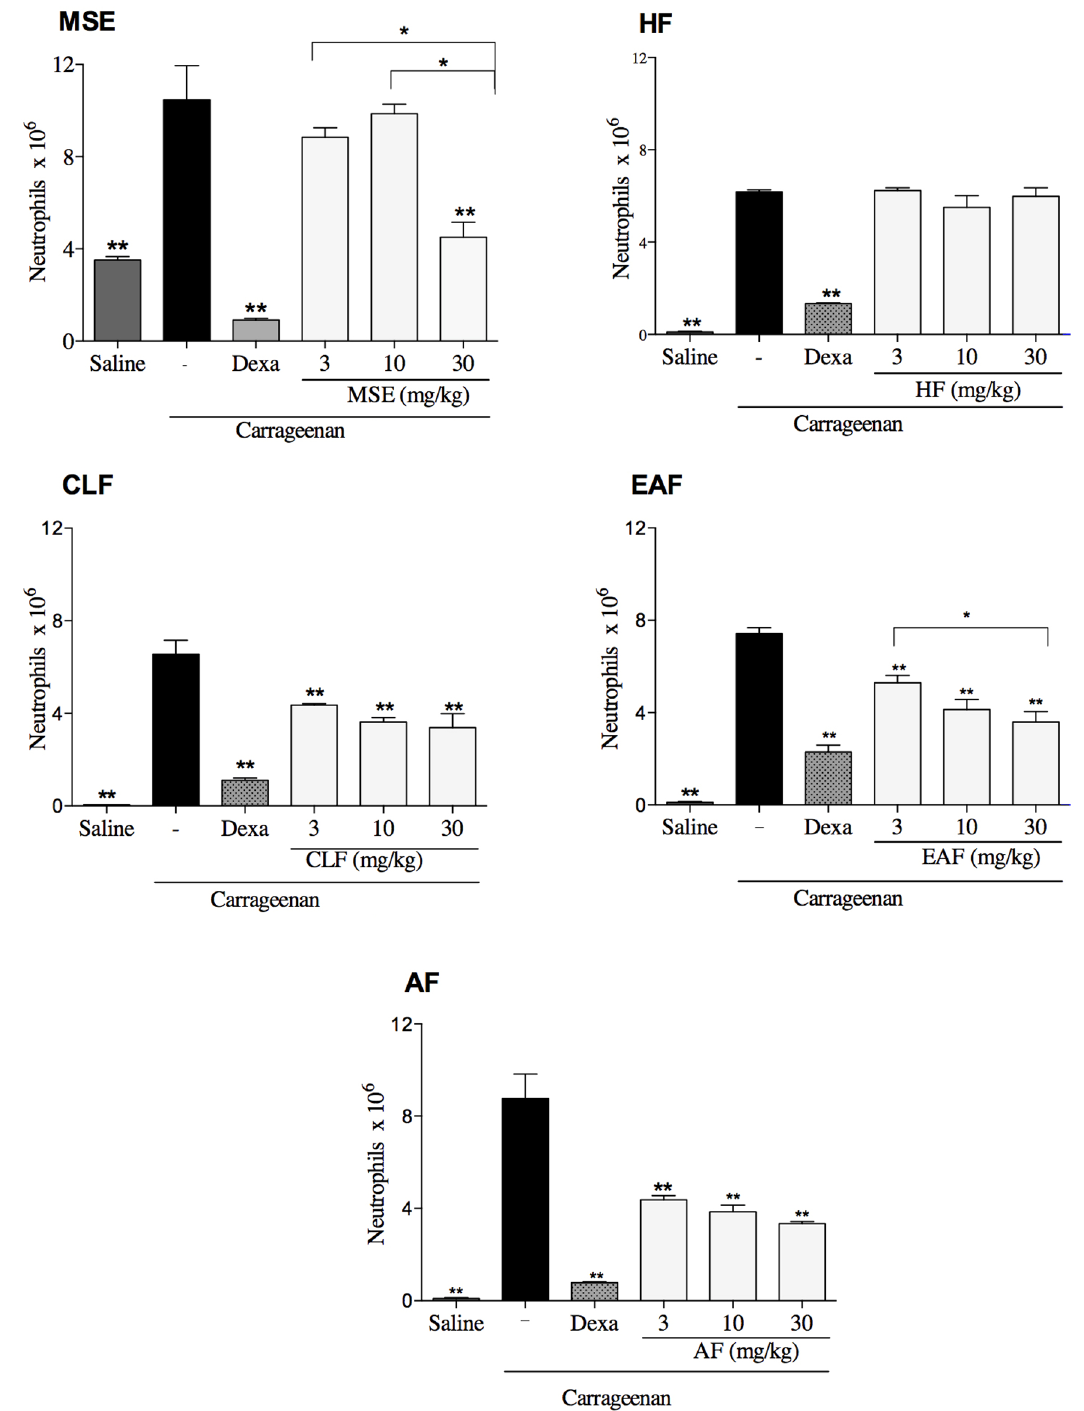
Fig 1. Inhibitory effect of the MSE, HF, CLF, EAF, AF on neutrophil migration into the peritoneal cavity induced by carrageenan. Neutrophil migration was determined 4 h after the injection of carrageenan 500 μ g/cavity. Mice previously treated with the vehicle, MSE (ethanol extract of M . sylvestris ), HF (hexane fraction), CLF (chloroform fraction), EAF (ethyl acetate fraction) and AF (aqueous fraction). The data are expressed as mean ± SD, n = 6. Symbols indicate statistical difference (p < 0.05, ANOVA, Tukey ’ s post-test) ** compared to the carrageenan group; * comparison between the concentrations tested of 3, 10 and 30 mg/kg.